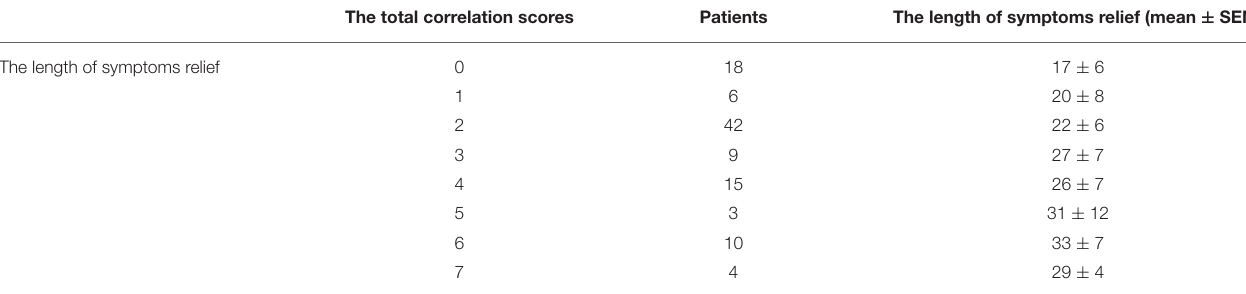
TABLE 9 | The length of symptoms relief in the scoring